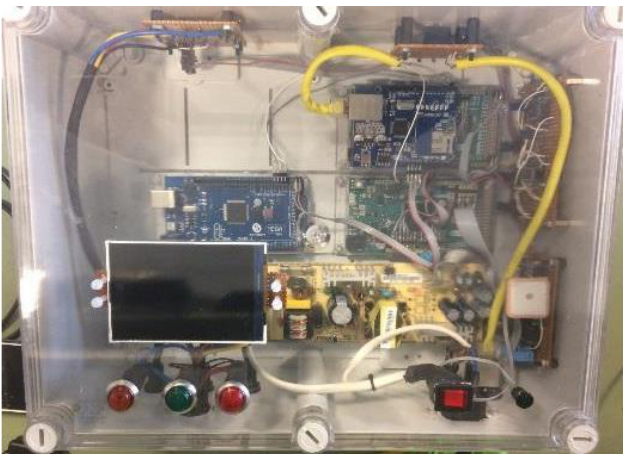
Figure 29. Full implementation of the proposed PMU : PhasorsCatchers.